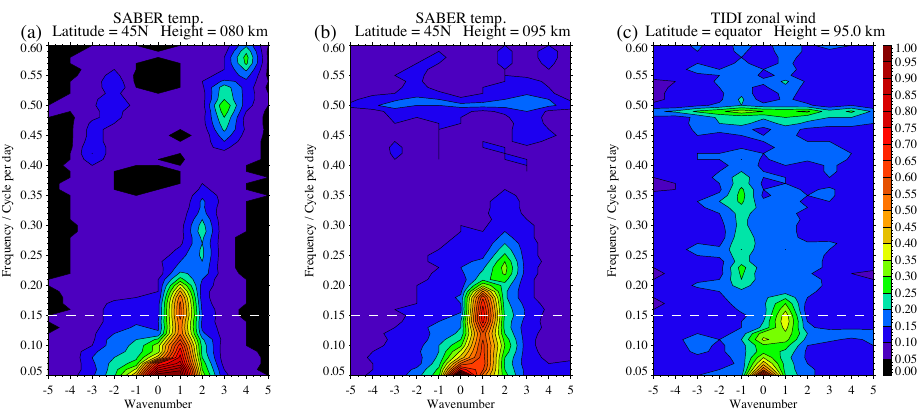
Figure 1. Normalized annual mean frequency–wavenumber power spectrum of SABER temperature at (a) 80 and (b) 95km at 45 ◦ N between the year 2002 and 2007. (c) is the same as (b) , but for TIDI zonal wind at 95km over the Equator. Positive (negative) values denote westward (eastward) propagation. The white dashed line denotes the frequency of 0.15cpd ( ∼ 6.5 days). The contour interval is 0.05cpd.